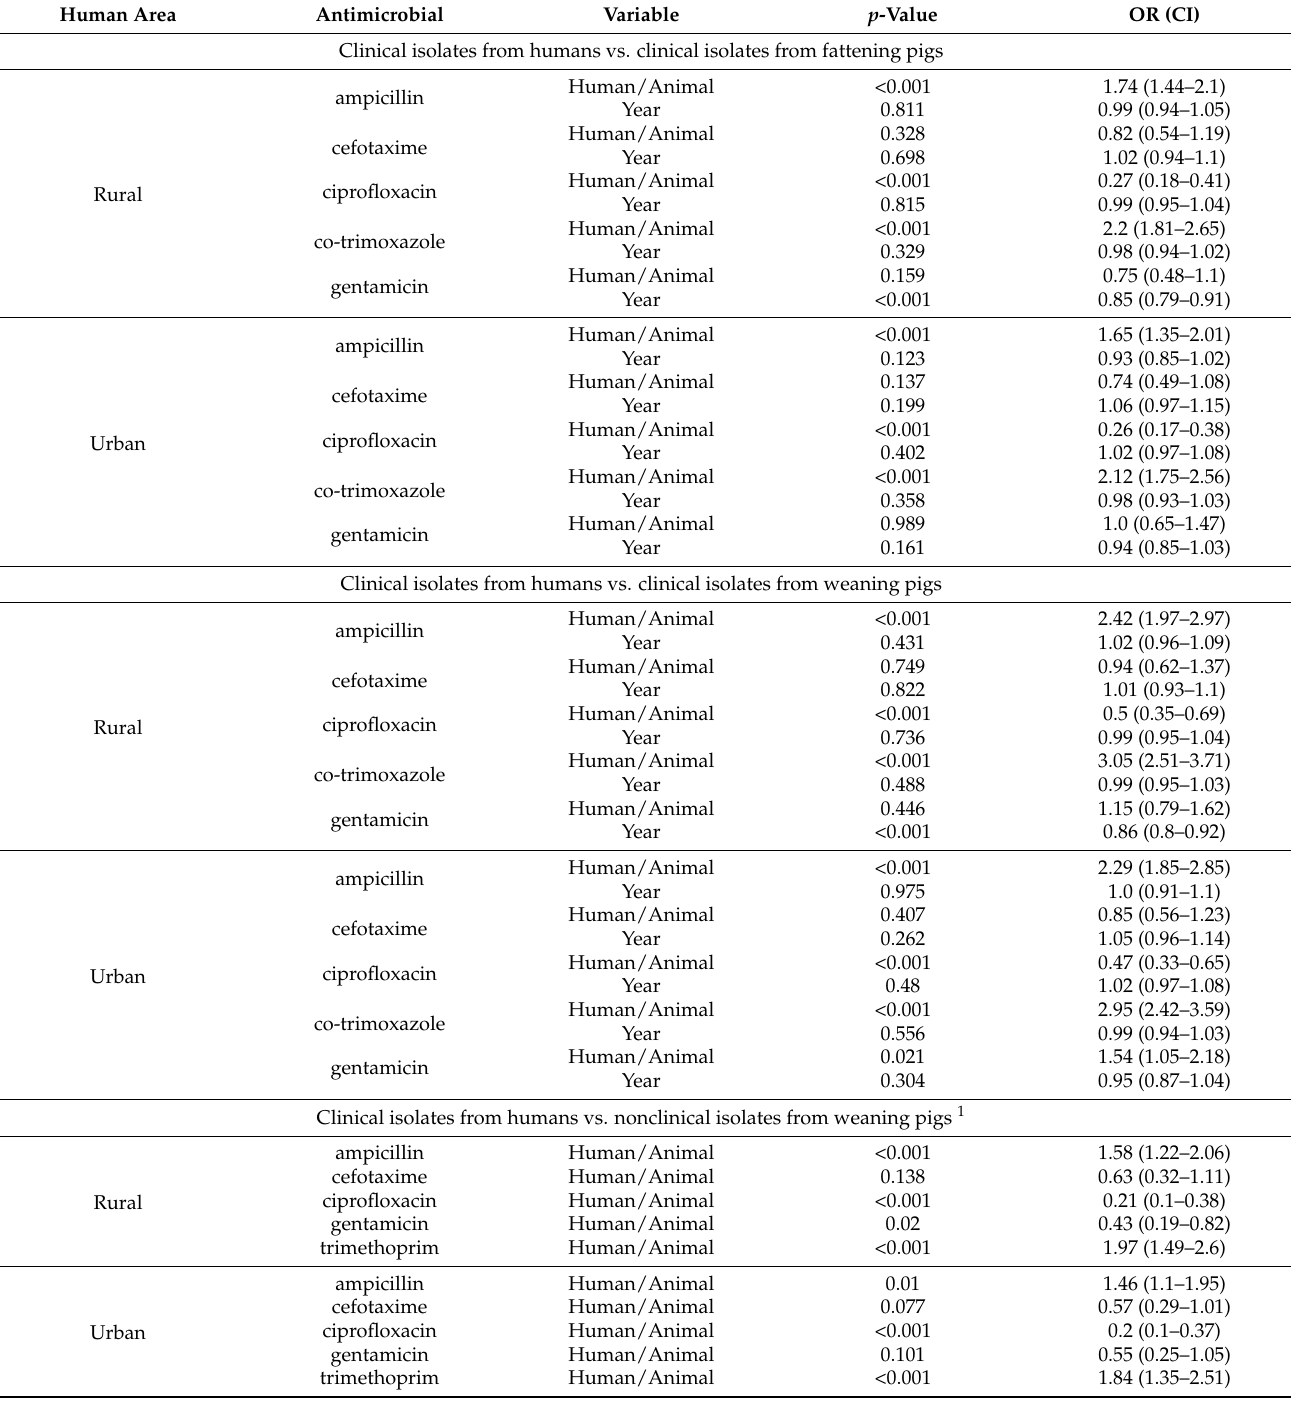
Table 2. Univariable logistic regression analyses between human isolates from rural and urban areas and pig